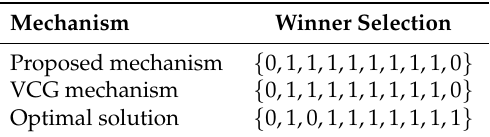
Table 3. Results of winner selection.